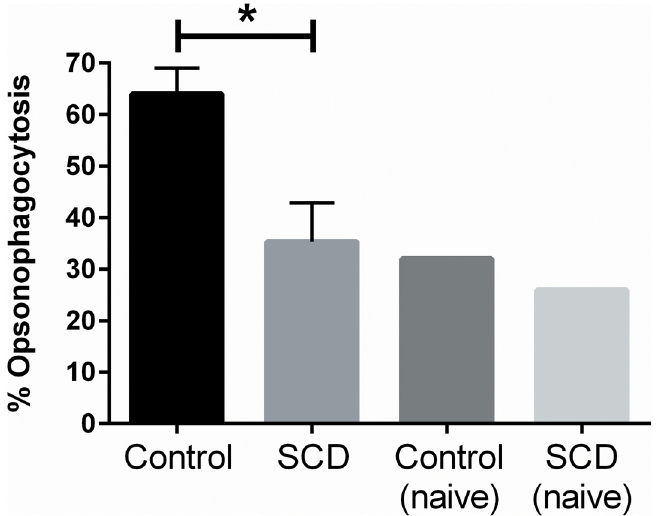
reported as the percentage of pneumococcal colonies that were not phagocytosed by macrophages when compared to “ no serum control ” wells. p < 0.05 as determined by a t-test. Comparisons to na ï ve mice were not performed as those samples were pooled.